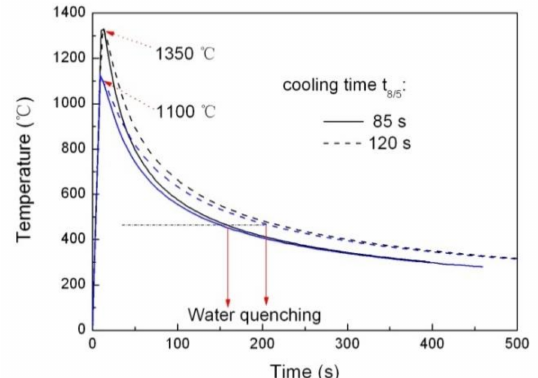
Figure 1. Typical thermal cycle curves with different peak temperatures and cooling times (water quenching process signified schematically with red